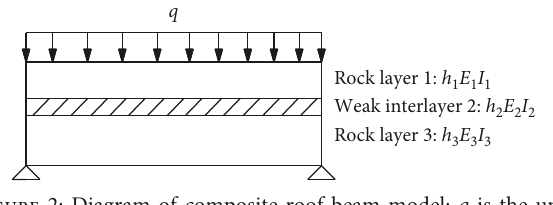
Figure 2: Diagram of composite roof beam model: q is the uni- formly distributed load of roof beam model; h 1 , h 2 , and h 3 are the thicknesses of each rock layer; E 1 , E 2 , and E 3 are the elasticity moduli of each rock layer; and I 1 , I 2 , and I 3 are the inertia moments of each rock layer.